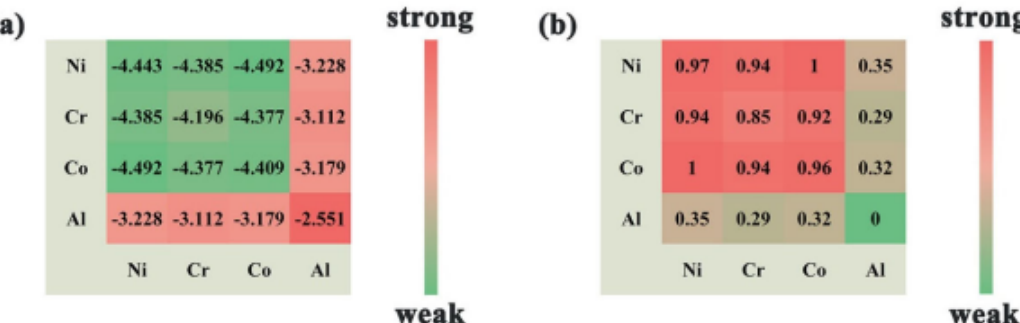
Figure 9. Cohesive energy ( a ) and chemical affinity ( b ) of CrCoNiAl 0.014 based upon the MD data (Units in Figure 4a: